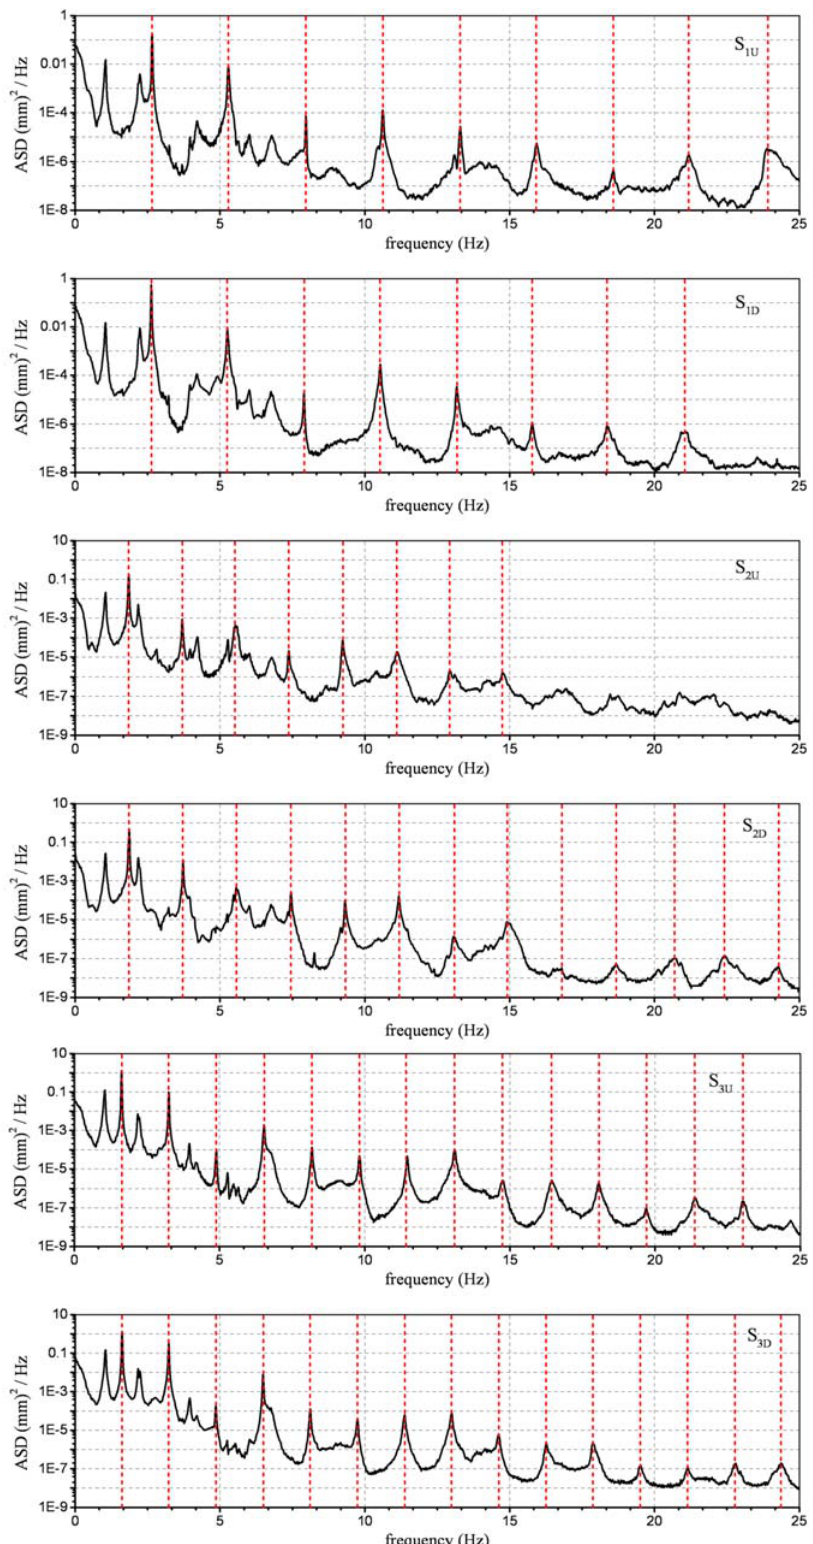
local resonant frequencies, marked with the vertical dashed lines, in the frequency range of analysis (0–25 Hz). Figure 10. Auto-spectra of the displacement data measured by the radar on the forestays , S , S , S , S and S S 1U 1D 2U 2D 3U 3D